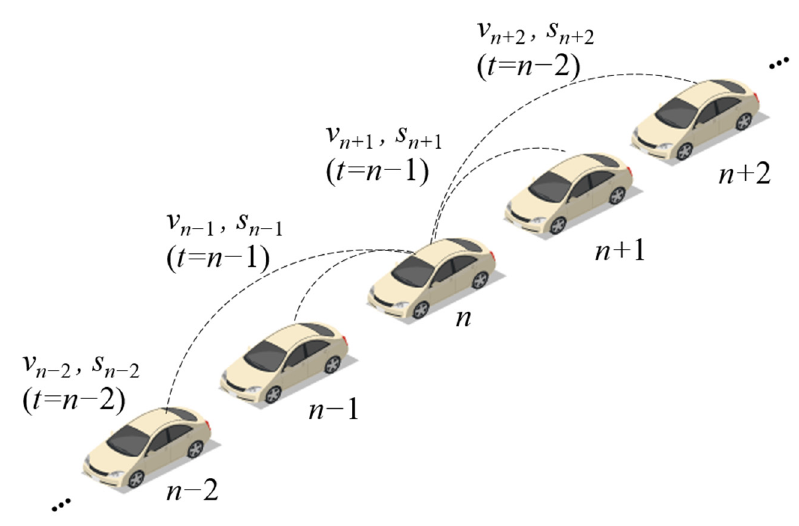
Figure 2. The information access for the nth vehicle in the DMVIS.